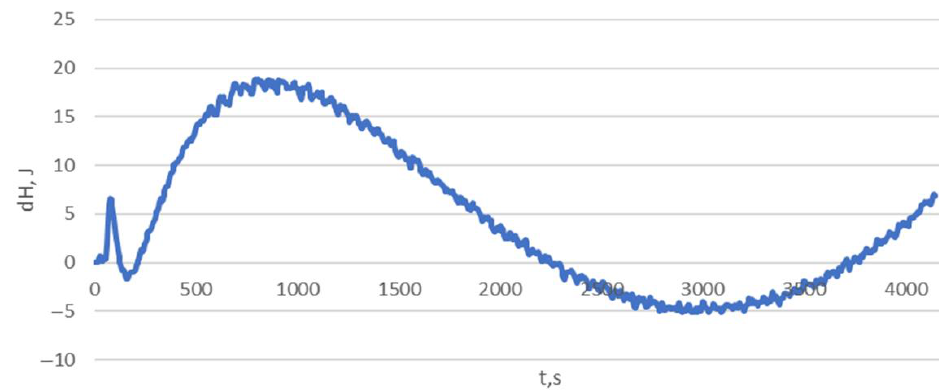
Figure 7. Residual power for T 0 Equation in (15) with coefficients from Table 4.